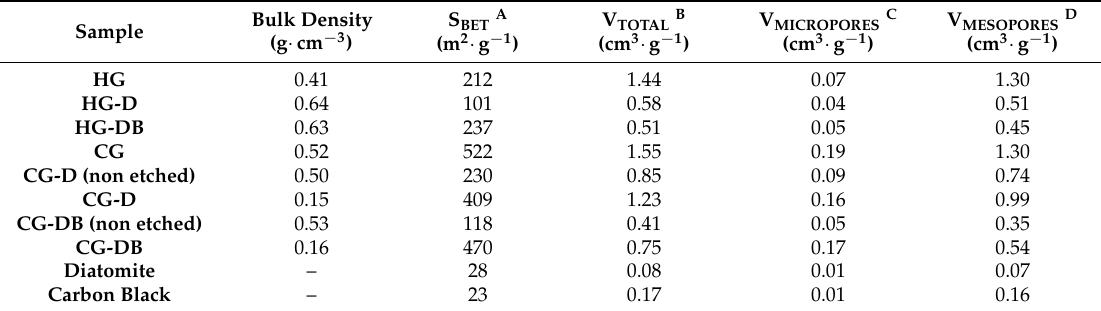
Table 1. Main textural characteristics of the monolithic aerogels obtained from N 2 adsorption isotherms at ´ 196 ˝ C. Aerogels before (HG) and after (CG) carbonization are compared. Sample